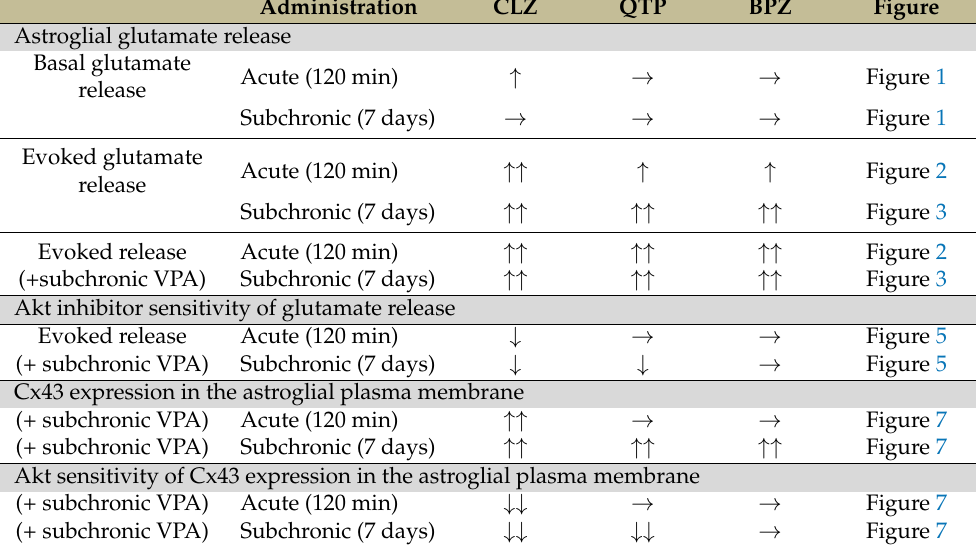
Table 1. Summary of the concentration-dependent effects of acute and subchronic administrations of CLZ, QTP and BPZ on astroglial L -glutamate release and Cx43 expression in the plasma